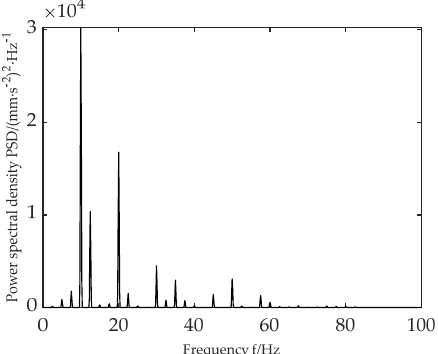
Figure 9. Roadside acceleration response spectral density.